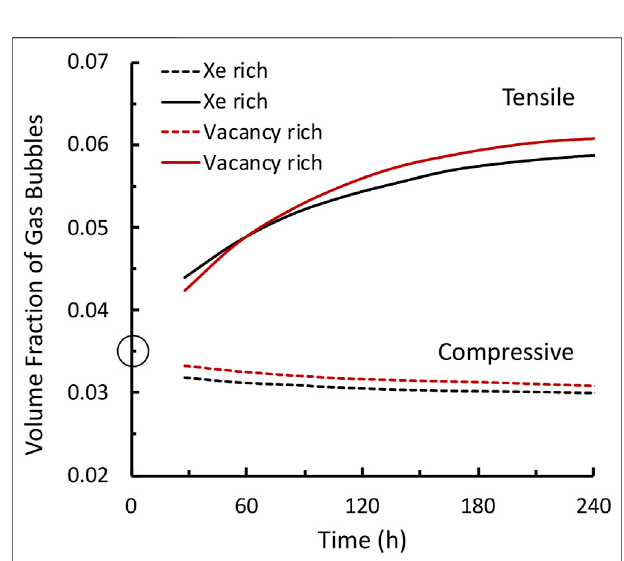
FIGURE 9 | Effect of local stress state and thermodynamic and kinetic properties of defects on gas bubble evolution.